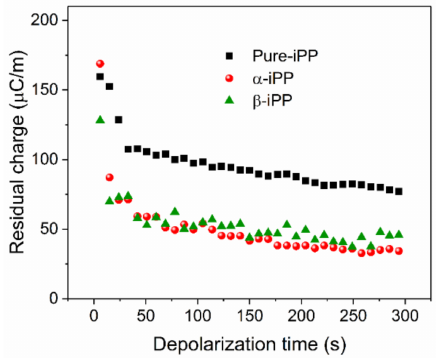
Figure 11. Residual charge in iPP samples after the removal of − 100 kV/mm at room